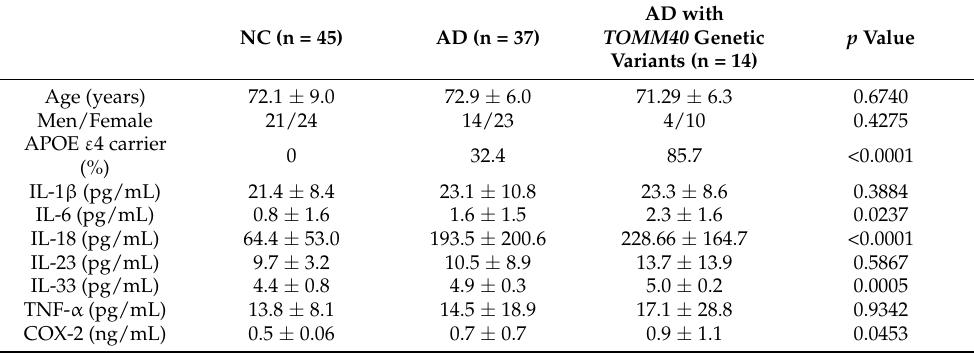
Figure 4. Plasma levels of IL-6, IL-18, IL-33, and COX-2 are significantly increased in AD patients carrying TOMM40 genetic variants. ( A – G ) ELISA assay showed that, compared to NC or AD patients, plasma levels of IL-6, IL-18, IL-33, and COX-2 were significantly upregulated in AD patients carrying TOMM40 genetic variants, including rs772262361, rs157581, and rs11556505. ** p < 0.01 compared with NC. Table 3. The plasma level of cytokines or COX-2 between NC and